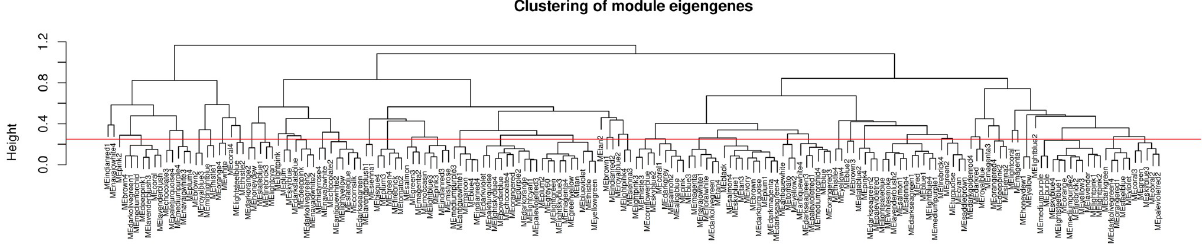
Fig 3. Clustering of 180 modules. The horizontal red line shows the height cut of 0.25, which corresponds to the correlation of 0.75, to merging the modules.